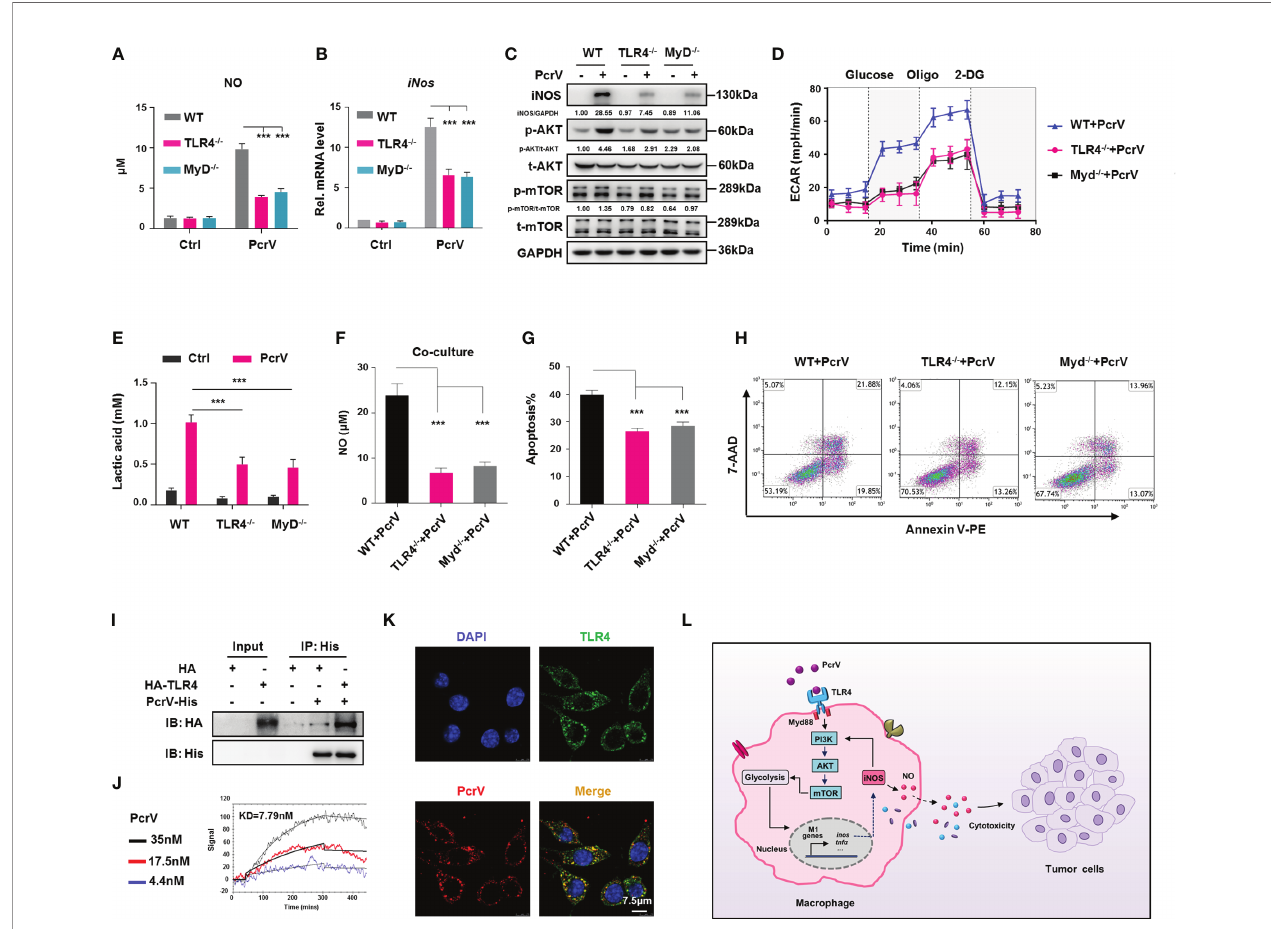
FIGURE 7 | TLR4/MyD88-mediated activation of the PI3K/AKT/mTOR-glycolysis-NO circuit promotes PcrV-induced M1 polarization and tumor-associated macrophage (TAM)-mediated cytotoxicity. Wild type (WT), TLR4 − / − , and MyD88 − / − TAMs were treated with PcrV (10 m g/ml) for 24 h (A) The nitric oxide (NO) level in the culture supernatant was measured using Griess reagent. (B) iNos expression levels were analyzed by RT-qPCR. (C) Protein levels were analyzed by Western blotting. (D) Assay for the extracellular acidi fi cation rate (ECAR). (E) Measurement of the lactic acid level in the culture supernatant. WT, TLR4 − / − , and MyD88 − / − bone marrow-derived macrophages (BMDMs) were pretreated with PcrV (10 m g/ml) for 24 h and then co-cultured with LLC cells for another 24 h (F) Detection of NO level in the culture medium. (G, H) The apoptosis of LLC cells was detected by FACS. (I) The lysates of HEK293T cells overexpressing recombinant human TLR4 were incubated with puri fi ed PcrV protein. A co-immunoprecipitation (Co-IP) assay and Western blotting were performed to detect the interaction between PcrV and TLR4. (J) Direct interaction between TLR4 and PcrV was analyzed using surface plasmon resonance (SPR). (K) PcrV/TLR4 co-colonization on Raw264.7 cells was visualized using immuno fl uorescence (IF) staining. (L) Schematic diagram of the molecular mechanism by which PcrV reeducates TAMs and enhances TAM- mediated antitumoral activity. Data were expressed as means ± SD and analyzed by unpaired Student ’ s t -test. *** p < 0.001. MyD indicates MyD88. TLR4, Toll-like receptor 4; MyD88, myeloid differentiation factor 88; LLC, Lewis lung cancer; FACS, fl uorescence-activated cell